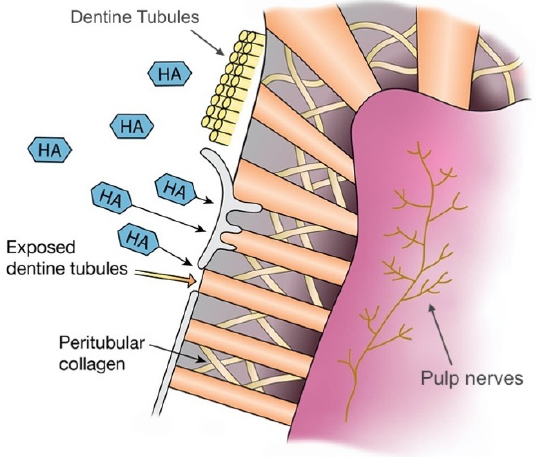
Figure 4. The mechanism of action of HA on the management of dentine hypersensitivity. HA can occlude the exposed dentinal tubules.